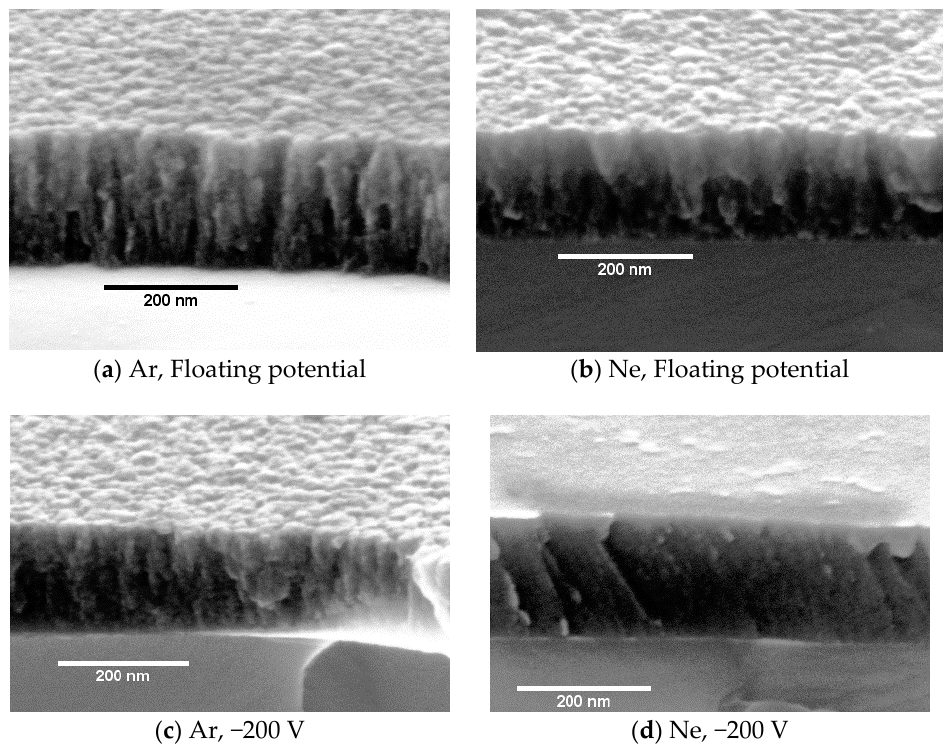
Figure 3. The cross-sectional SEM images of 180-nm thick Ar-HiPIMS and Ne-HiPIMS DLC films deposited on Si at the electrically floating potential and − 200 V substrate bias. All samples were 20° tilted to show both the surface and the cleaved cross-section.